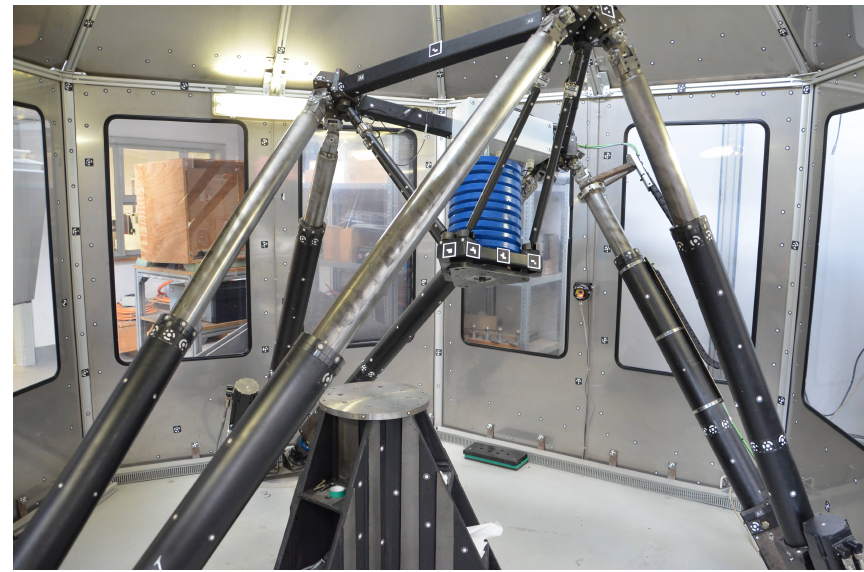
Figure 6. Validation of the approach through identification of known